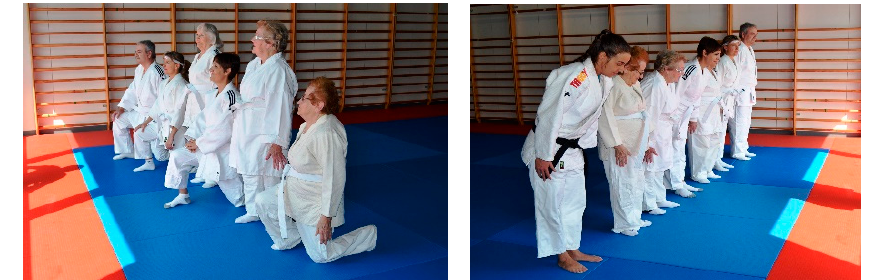
Figure 4. Ways to greet.